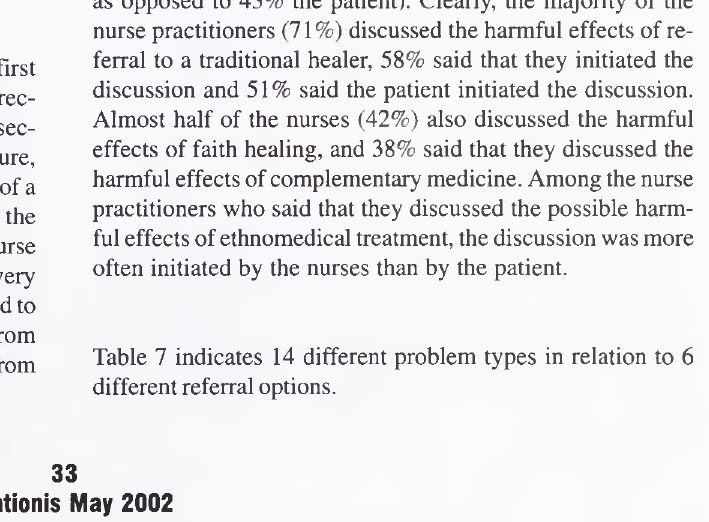
Table 7 indicates 14 different problem types in relation to 6 different referral